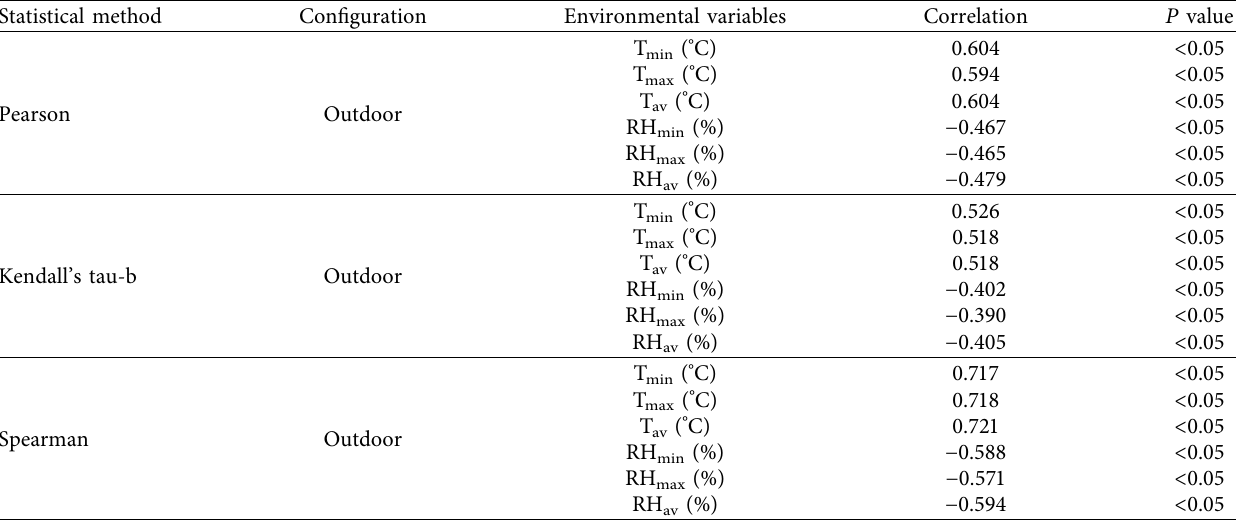
Table 4: Pearson, Kendall’s tau-b, and Spearman correlations between meteorological factors and COVID-19-infected cases for outdoor configuration.